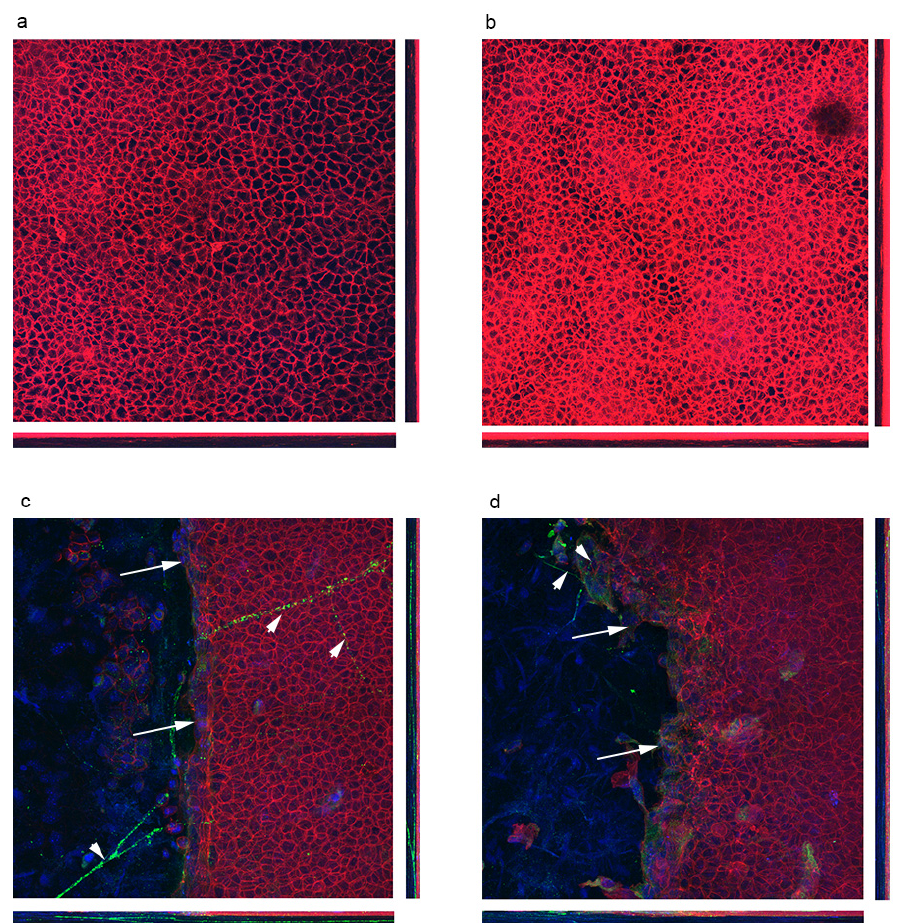
Figure 7. Corneas stained for fibronectin and counter stained with rhodamine phalloidin. 40 µ m of 2 × 2 tile z-sections were taken and presented as maximum intensity with orthogonal sections. ( a ) 15-week unwounded control ( b ) 15-week unwounded DiO ( c ) 15-week control 20 h after wounding ( d ) 15-week DiO 20 h after wounding.